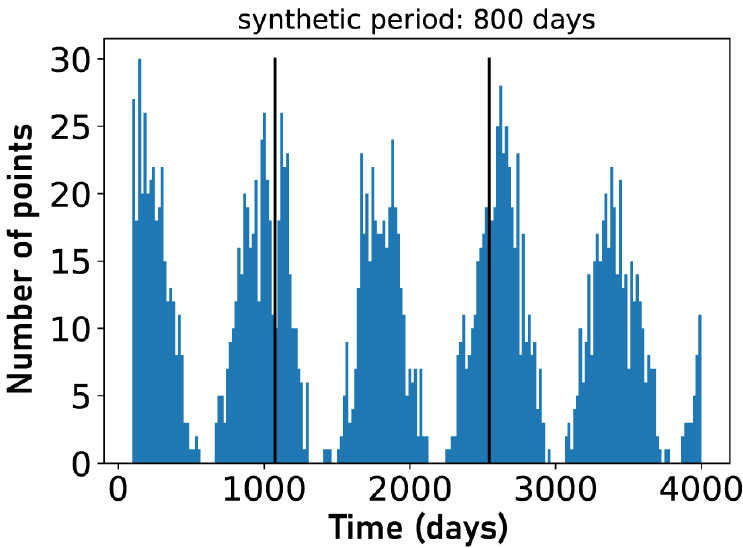
Figure 7. Example of periodically distributed synthetic outliers. We randomly select an ∼ 4 years segment (located between the two vertical black lines) for analysis.